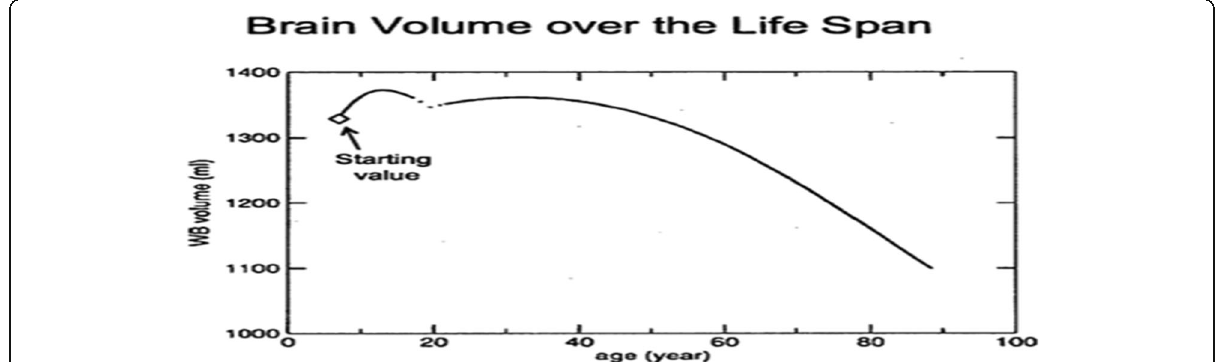
Fig. 1 Relation between age and whole brain volume